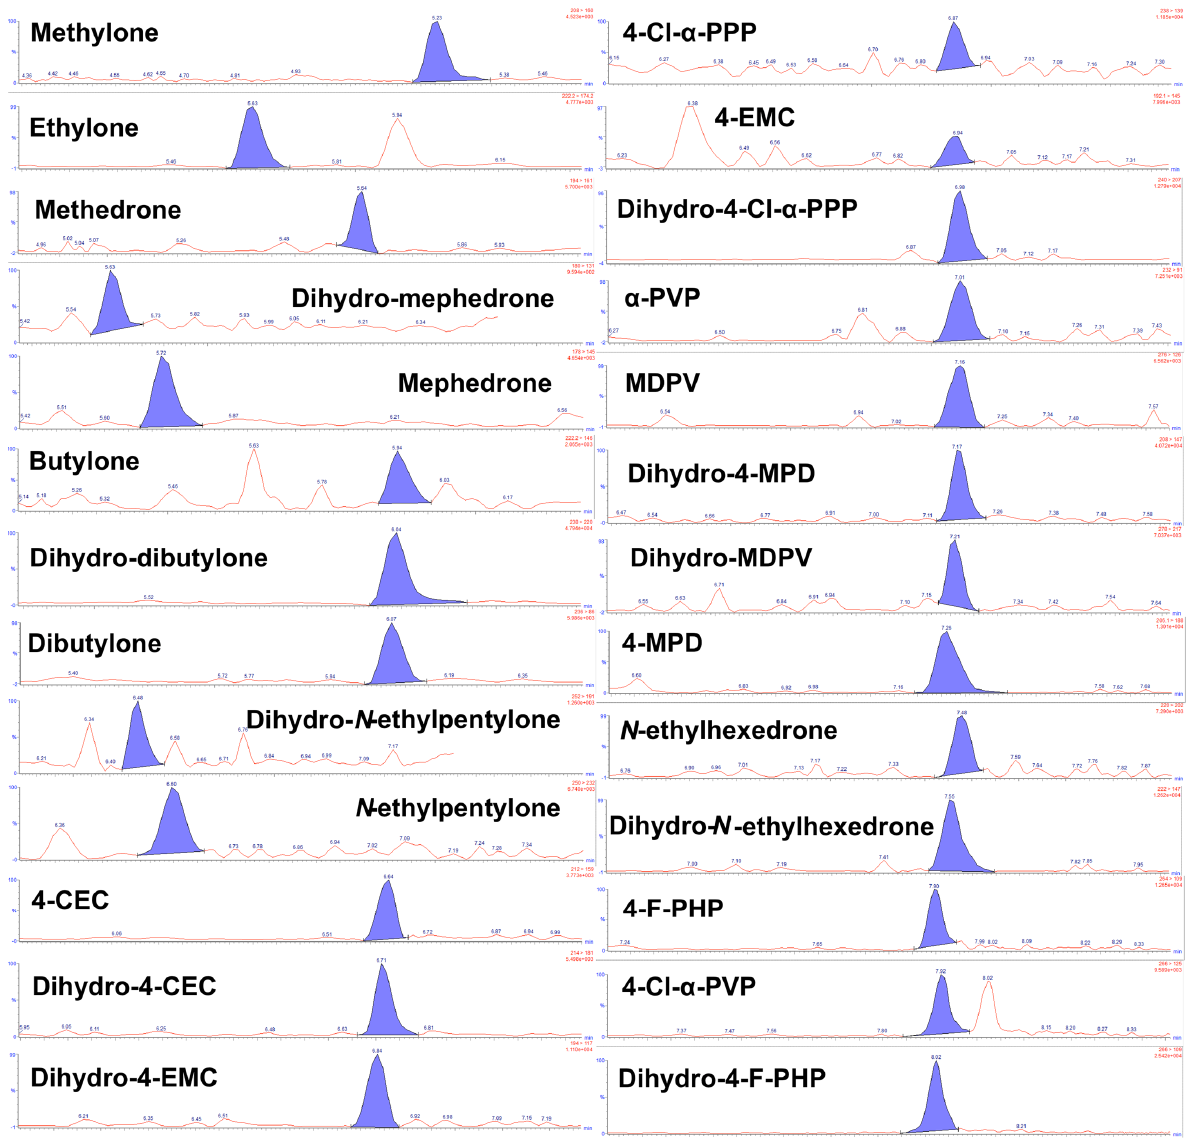
Figure 3. LC–MS/MS chromatograms of quantifier MRM transition (see Table 1) monitored for SCt analytes ( n = 26) at the LOQ (1 ng/mL).